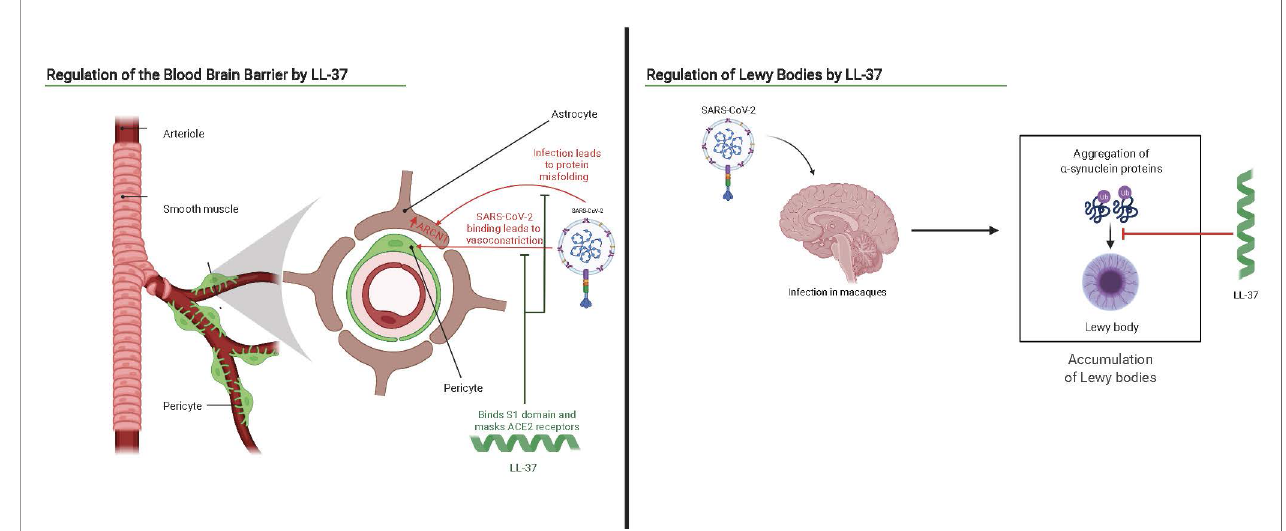
FIGURE 4 | Interaction scheme of SARS-CoV-2 and the brain overlaid with potential antagonistic or therapeutic bene fi ts of LL-37. Adapted from “ Brain Vascular System ” and “ Progression of Parkinson ’ s Disease by the Substantia Niagra ” , by BioRender.com (2021). Retrieved from